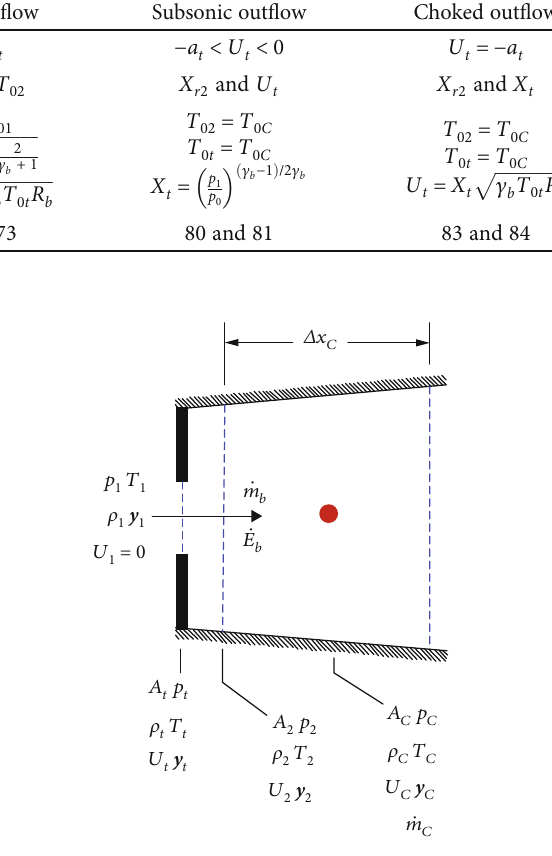
Figure 10: Mass and energy fl ow rate across